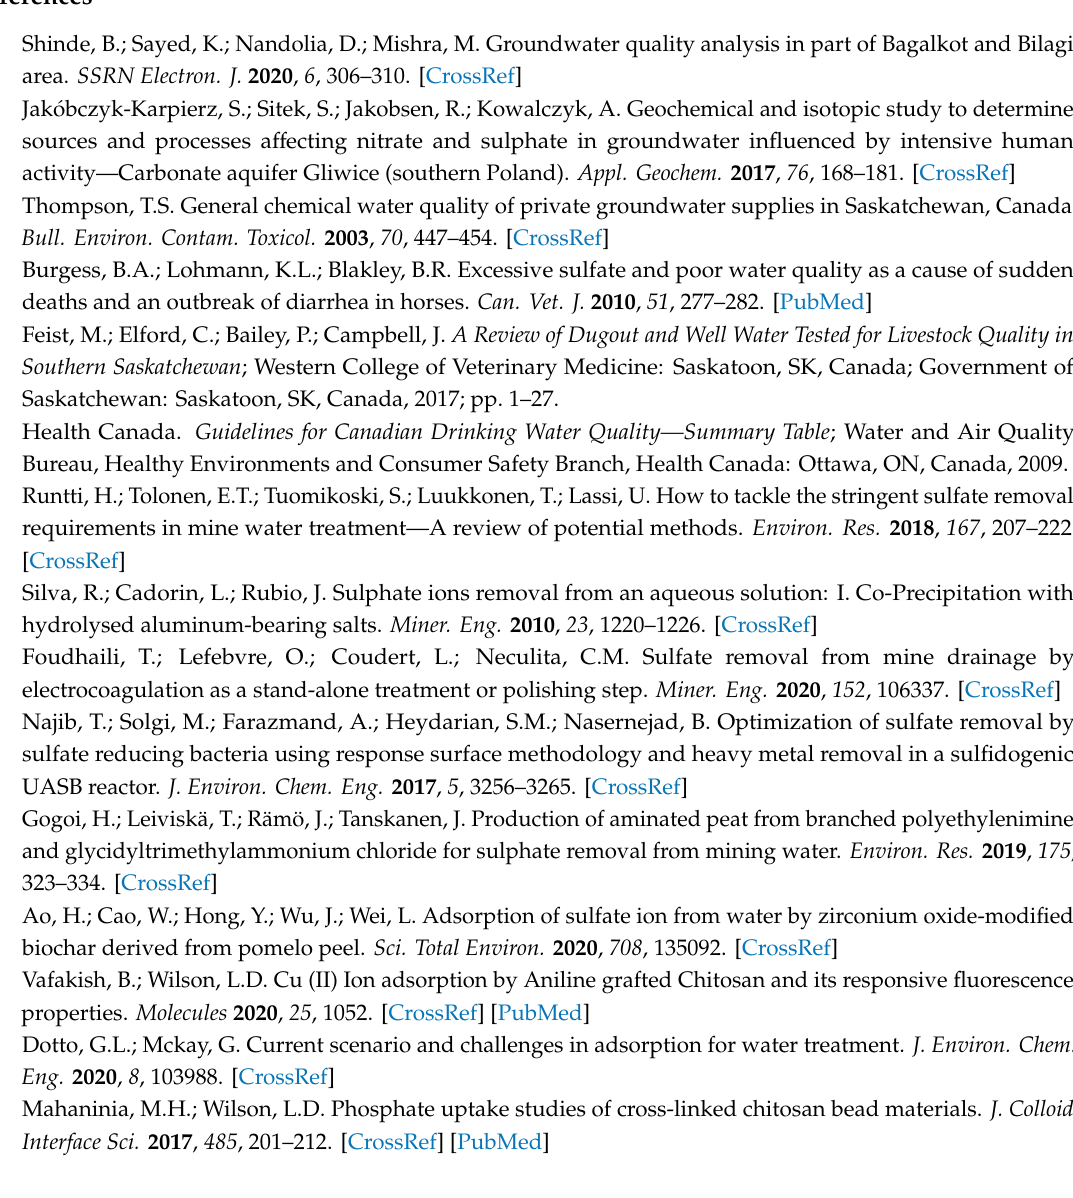
Figure S1: ( a ) bed depth, ( b ) influent concentration, ( c ) flow rate. Linear plots of Thomas model at di ff erent initial sulphate concentration (pH = 4.5, temperature 25 ◦ C, bed height 200 mm, flow rate 3 mL / min); Figure S2: Breakthrough curves of sulphate adsorption by Ca–CP for cycle 1 to cycle 4 (pH 4.5, bed height of 200 mm, flow rate of 3 mL / min, initial sulphate concentration of 1000 mg /